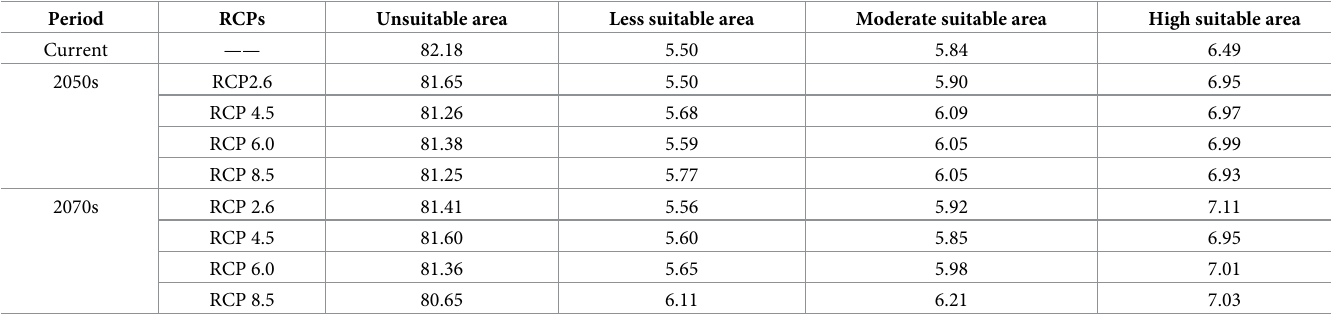
We use ArcGIS 10.3 software to extract the area of different suitable areas (Table 2). The total suitable area for B . platyphylla was 168.75 × 10 4 km 2 ; less suitable area (52.05 × 10 4 km 2 ), moderately suitable area (55.28 × 10 4 km 2 ), and highly suitable area (61.42 × 10 4 km 2 ) accounted for 5.50%, 5.84%, and 6.49% of the total area, respectively. Among provinces, Sich- uan Province had the largest total suitable area, accounting for 12.38% of the total suitable area in China, as well as the largest highly suitable area, accounting for 18.63% of the highly suitable area in China. Shaanxi Province had the largest moderately suitable area, accounting for